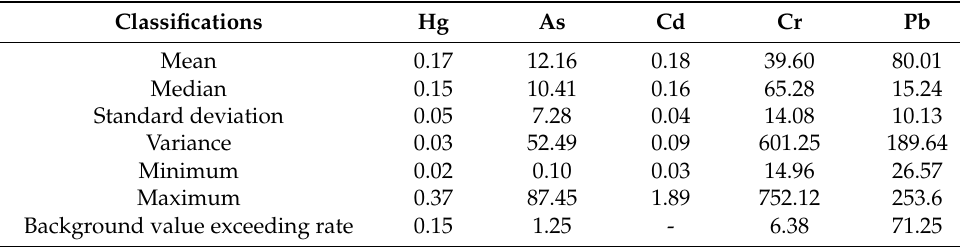
Background value exceeding rate